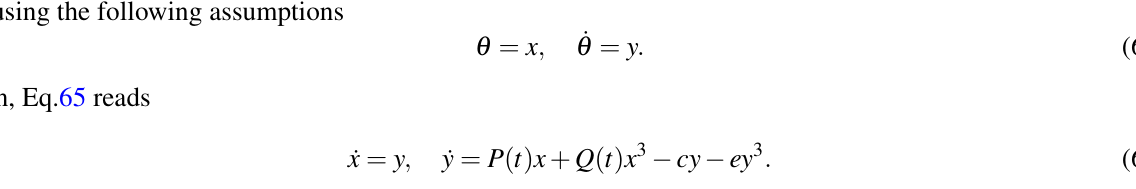
Fig. 2 Existence of stable limit cycle with α = 10, β = 1, c = 0 . 1, e = 0 . 05, Γ = 1 and ω =